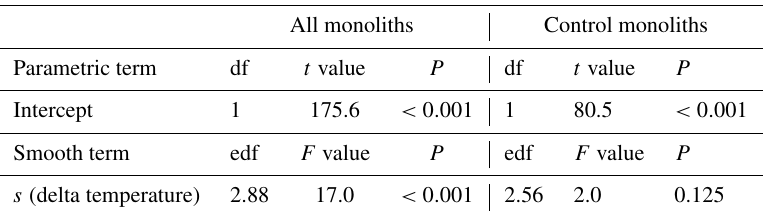
Table B5. Summary of analyses for the effects of temperature change (delta temperature) induced by the climate change treatments root carbon stock (Root C) at 2017 after 5 years of experimental treatment. F and t values and approximate P values refer to a generalized additive model that used a smooth term to delta temperature.